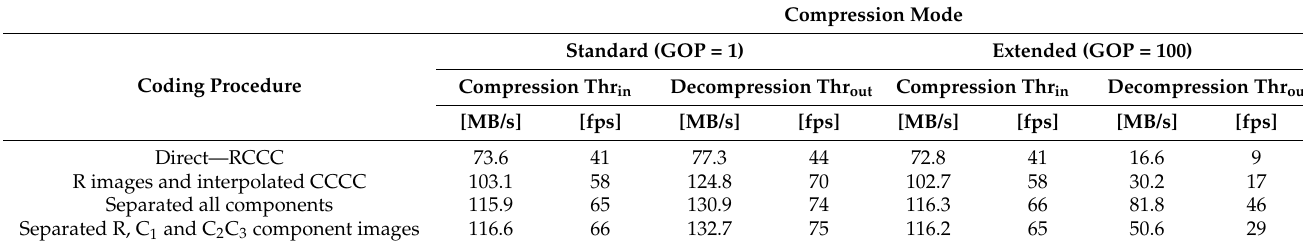
Table 3. Throughputs for various lossless coding procedures and compression